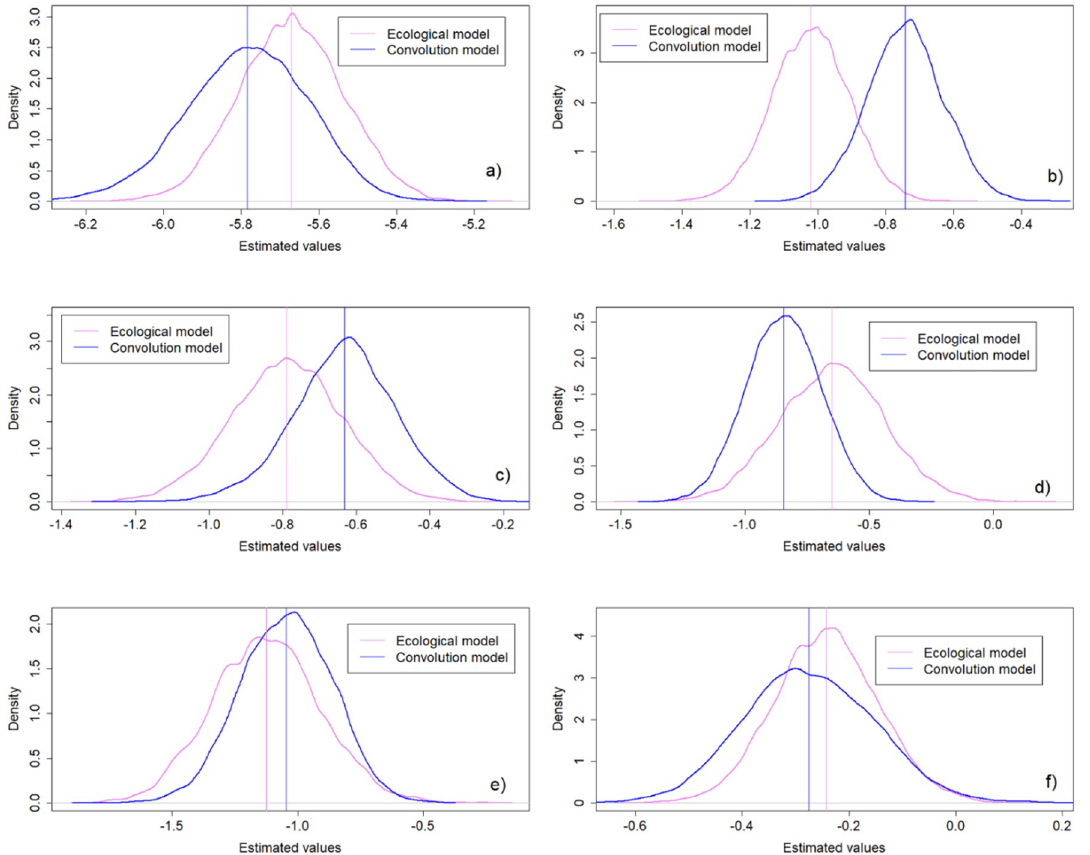
Figure 2. Covariate regression coefficients density plots for the convolution and ecological models. ( a ) Intercept, ( b ) Normalized Difference Water Index, ( c ) Day Land Surface Temperature, ( d ) Night Land Surface Temperature, ( e ) Elevation, and ( f ) Nearest Distance to Water Bodies. Table 2. Estimated regression coefficients (mean and 95% credible intervals).